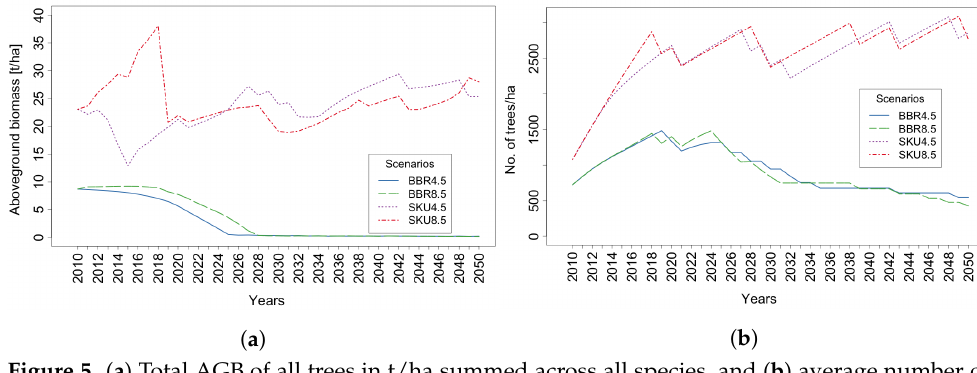
Figure 5. ( a ) Total AGB of all trees in t/ha summed across all species, and ( b ) average number of trees in one hectare summed across all species.